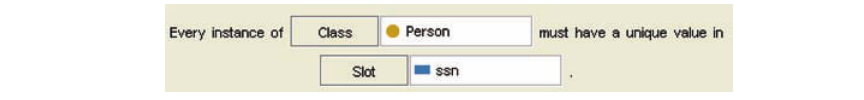
Fig. 4. The first axiom defined using EZPAL Tab plug-in (Hou et al.